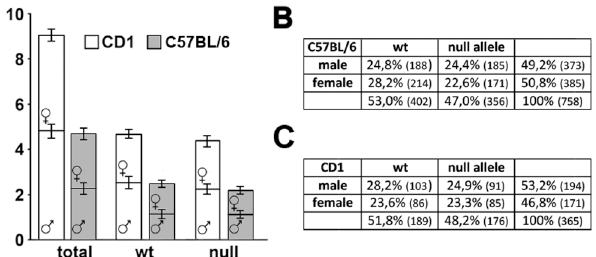
Fig 1. CD1 Mecp2 tm1.1Bird-/X females have large litters with balanced Mecp2 alleles. A : Litters obtained crossing CD1 Mecp2 -/X heterozygous females and wt males are larger (an average of 9,13 ± 0,39 pups per litter) than those from the same crossing in the B6 background (an average of 4,73 ± 0,17 pups per litter). The percentage of males and females is similar in each litter (roughly 50%) for both the genetic backgrounds. B : Although not statistically significant, in the B6 litters the frequency of the null allele results slightly lower than the expected 50%. C : The null allele is normally represented in the CD1 progenies. Statistical significance was evaluated through Chi-square analysis, significance is considered when p < 0,05.